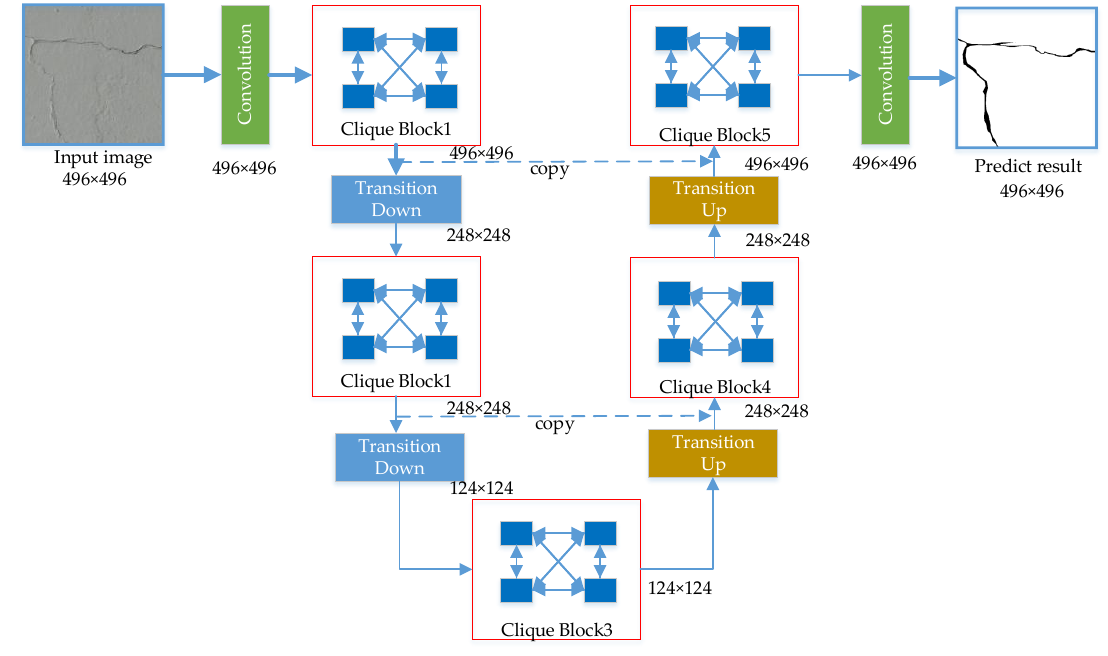
Figure 5. Overview of the proposed crack detection framework: U-CliqueNet.